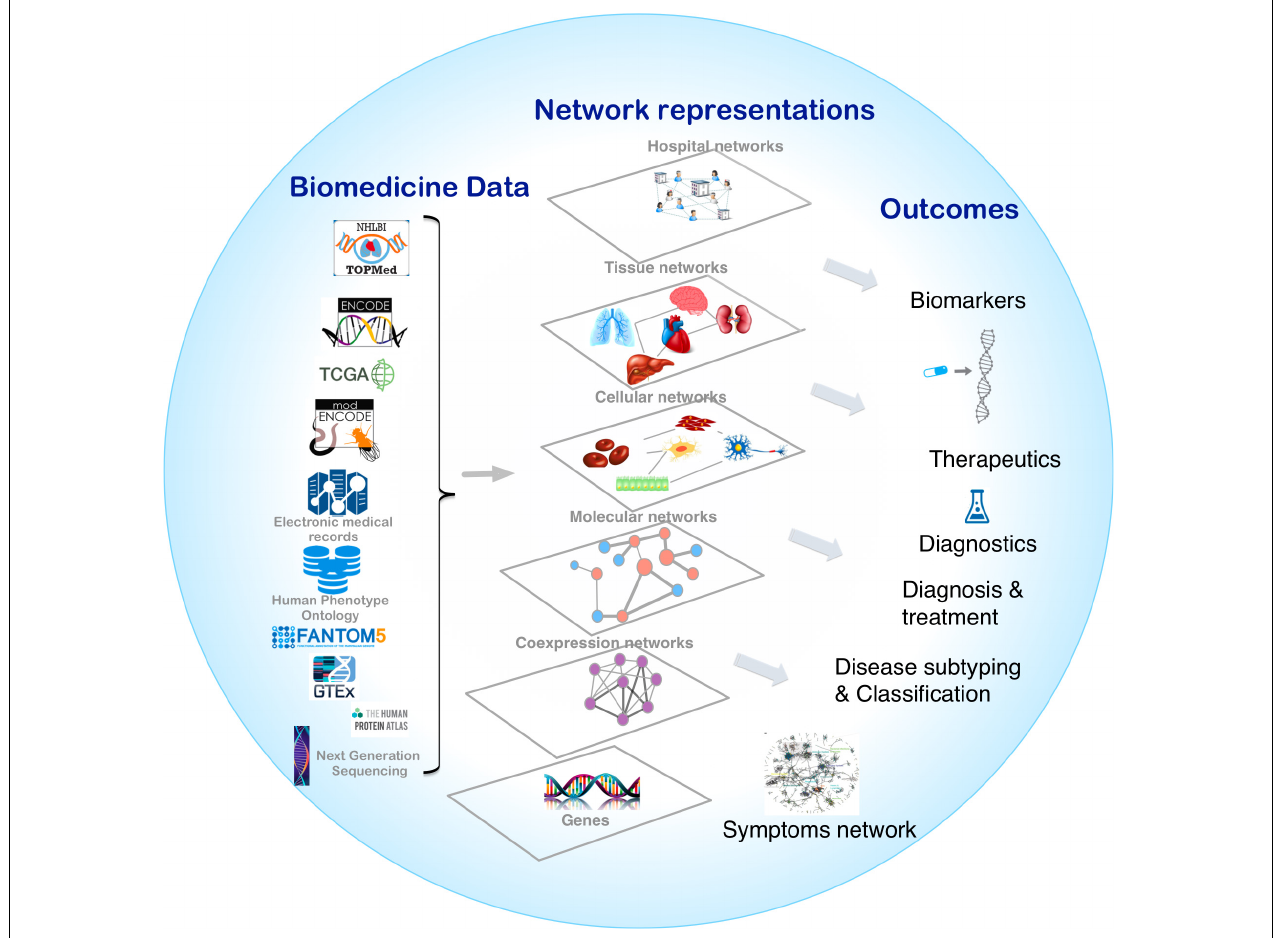
FIGURE 1 | Overview of network medicine approach depicting various biomedical data types discussed at length in the manuscript, along with network representations that simplify different components of multiple omics data from the genome, transcriptome, proteome, and metabolome as nodes that are connected by links (edges). Combining biomedical data with the appropriate network modeling approach allows derivation of disease associated information and outcomes like biomarkers, therapeutics targets, phenotype-specific genes and interactions, and disease